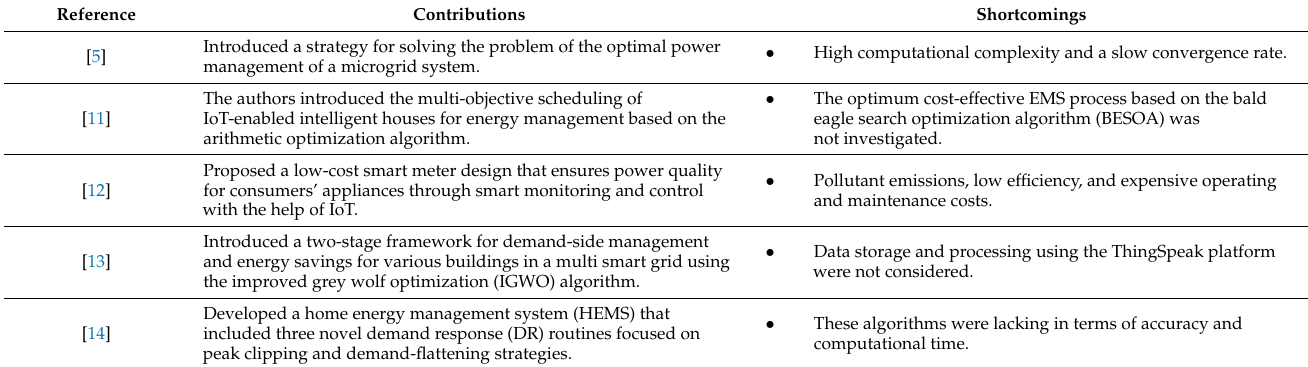
Table 1. Contributions vs. shortcomings of greatest recent studies concerning demand-side manage- ment